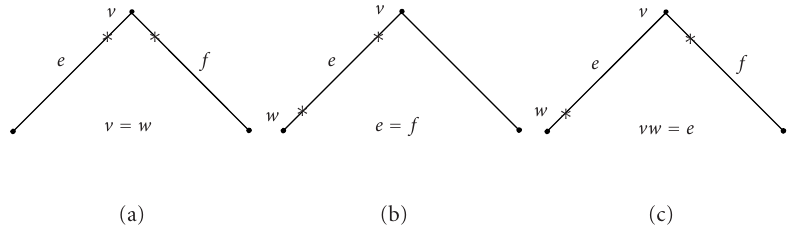
Figure 1.1. Cases of two incidences being